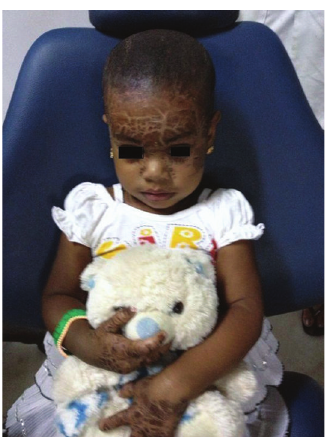
Figure 3: Scaly lesions present in palmoplantar